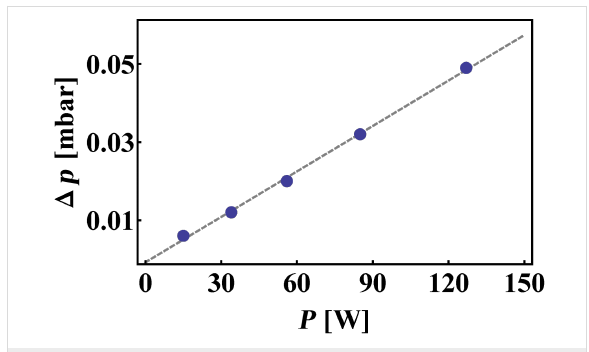
Figure 2: Measured linear pressure increase in chamber A as a func- tion of magnetron